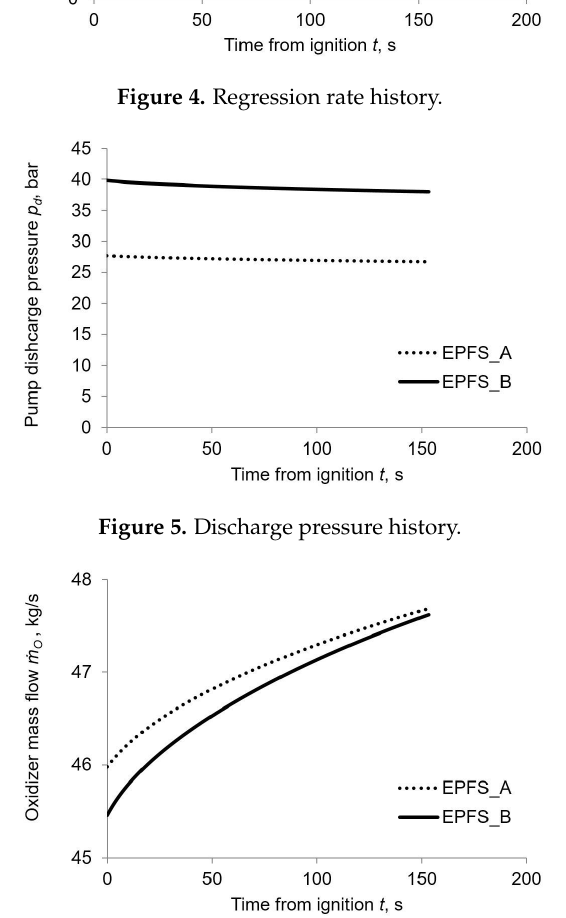
Figure 6. Oxidizer mass flow